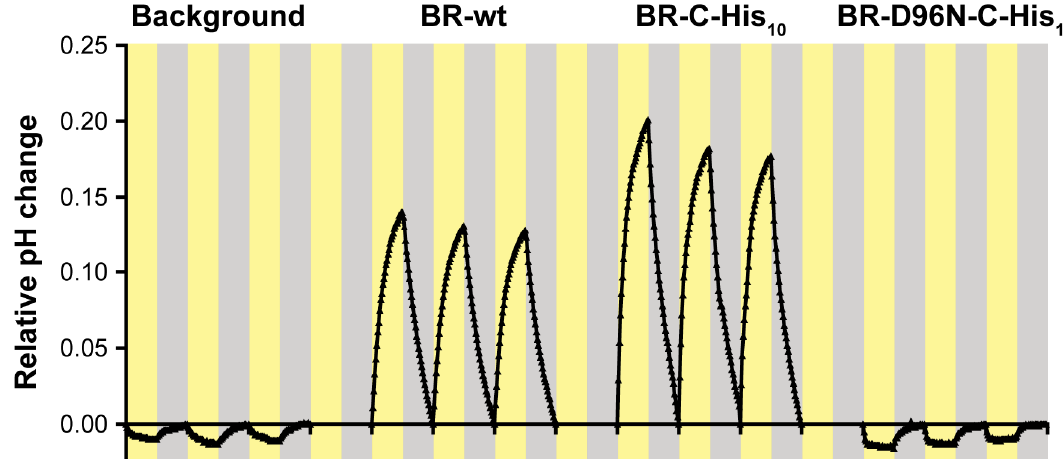
Figure 4. Photoactivity of BR versions reconstituted into liposomes. Drift-corrected photoactivity measurements of measuring solution (Background) or BR-wt, BR-C-His 10 and BR-D98N-C-His 10 proteoliposomes. Yellow and gray shading indicate 15 min light and dark cycles. The pH of the extracellular solution of proteoliposomes containing functional BR versions (wt and C-His 10 ) increases upon illumination, demonstrating the proton pumping activity and thus functional insertion. In contrast BR-D96N-C-His 10 proteoliposomes exhibit only background level pH change upon illumination since D96N is a BR version with defective proton pumping activity. All proteoliposomes were reconstituted with the same amount of protein; thus, the increased pH change of the His-tagged version is either due to higher protein activity or more efficient reconstitution.